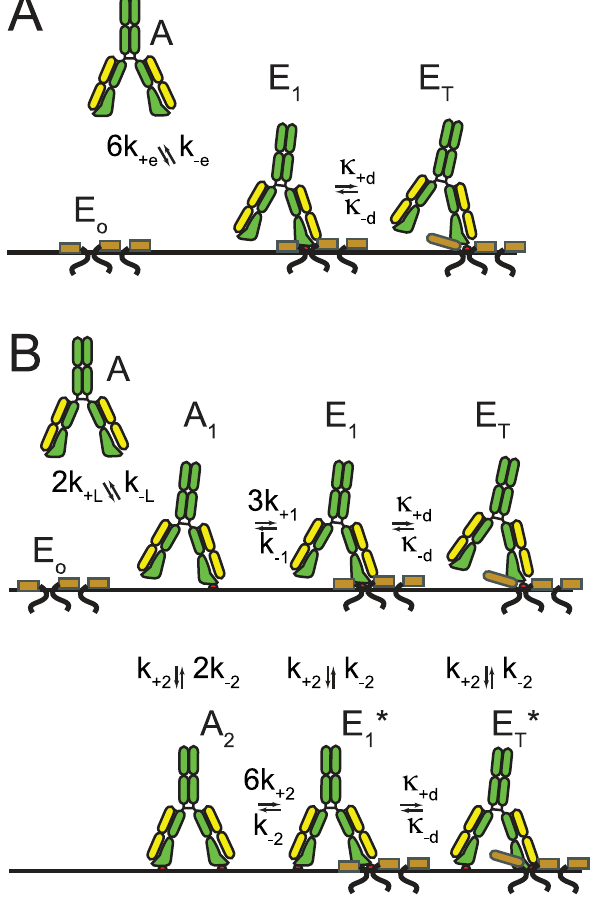
Figure 4. Binding scheme for a polyreactive antibody. A. The binding reactions when the antibody binding sites cannot bind directly to lipids in the membrane. B. The binding reactions when the antibody first binds to lipid in the membrane and then interacts with the MPER. K 2 ~ k z 2 = k { 2 is the surface equilibrium cross-linking constant for an antibody with one site free and one site bound to the membrane or the MPER binding to the membrane to form a bivalent attachment.